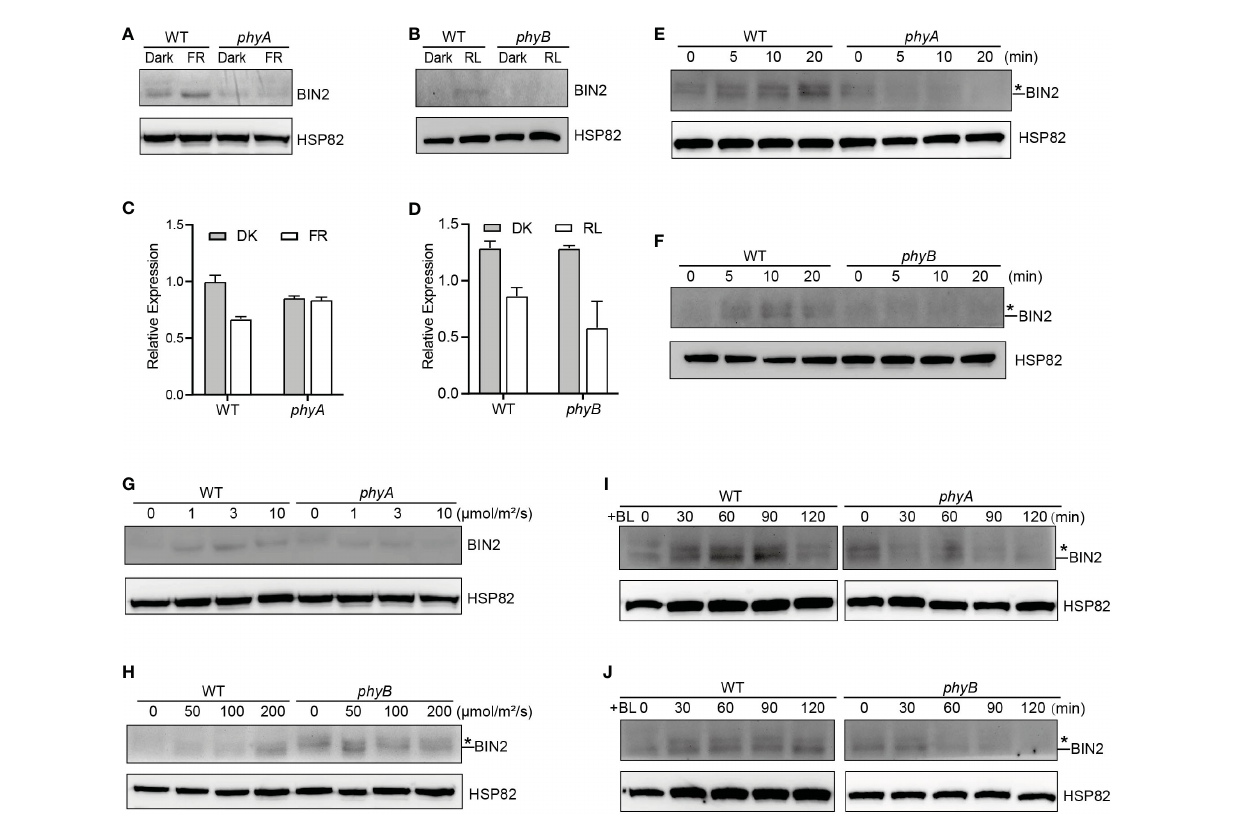
FIGURE 1 phyA and phyB Mediate Far-Red and Red lights Inhibition of BL-Induced Degradation of BIN2 Protein. (A, B) Western blotting assays showing phyA- and phyB-mediated far-red or red light inhibition of degradation of BIN2 protein. WT, phyA and phyB mutant seedlings were grown on MS plates in continuous darkness (DK) or far-red light (FR, 1 m mol/m 2 /s) (A) or red light (R, 50 m mol/m 2 /s) (B) for 5 d. (C, D) RT-qPCR assays showing the regulation of BIN2 expression by phyA or phyB in (A) and (B) . Data correspond to the mean and standard deviation from three technical replicates. (E, F) Western blotting assays showing the effects of different exposure times of far-red or red light on the degradation of BIN2 protein. WT, phyA and phyB mutant seedlings were grown on MS plates supplemented with 2 µM BRZ in darkness for 7 d, and then exposed to far-red light (10 m mol/ m 2 /s) (E) or red light (100 m mol/m 2 /s) (F) for the indicated lengths of time. (G, H) Western blot assays showing the effects of far-red or red light intensity on the degradation of BIN2 protein. WT and phyA mutant seedlings were grown on MS plates in far-red light at the fl uence rates of 0, 1, 3, and 10 µmol/m 2 /s for 5 d, respectively (G) ; WT and phyB mutant seedlings were grown on MS plates supplemented with 2 µM BRZ in darkness for 7 d, and then exposed to the indicated light intensities of red light (H) for 30 min . (I, J) Western blot assays showing the effects of phyA or phyB on the BL-induced degradation of BIN2 protein. WT, phyA and phyB mutant seedlings were grown on MS plates supplemented with 2 m M BRZ in darkness for 7 d, and then treated with 1 m M BL, and then exposed to far-red (10 m mol/m 2 /s) (I) or red light (100 m mol/m 2 /s) (J) for the indicated lengths of time. Asterisks shown in (E) , (F) , (H) , (I) , and (J) denote the possible modi fi ed BIN2 protein upon BRZ